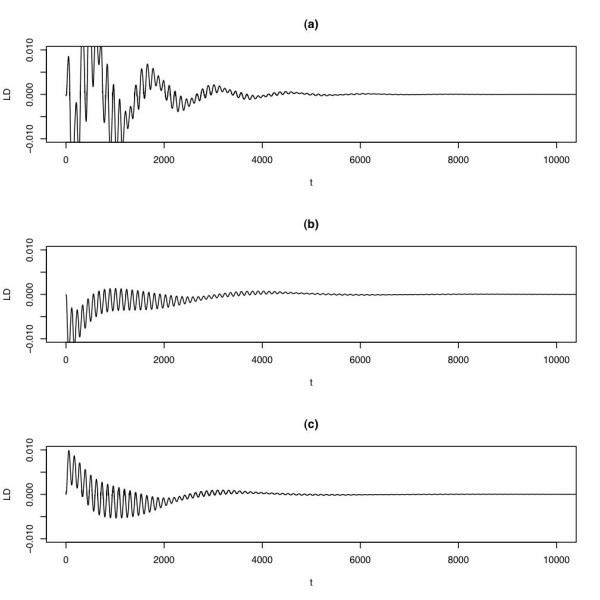
Typical simulation run in the deterministic versions of the standard model (a), the sequential-updating model (b), and the continuous-time model (c). The variable t represents the number of host generations. The figures show the LD oscillations during 10000 host generations. The following parameters were used: rmm = 0.1, sH = sP = 0.05.